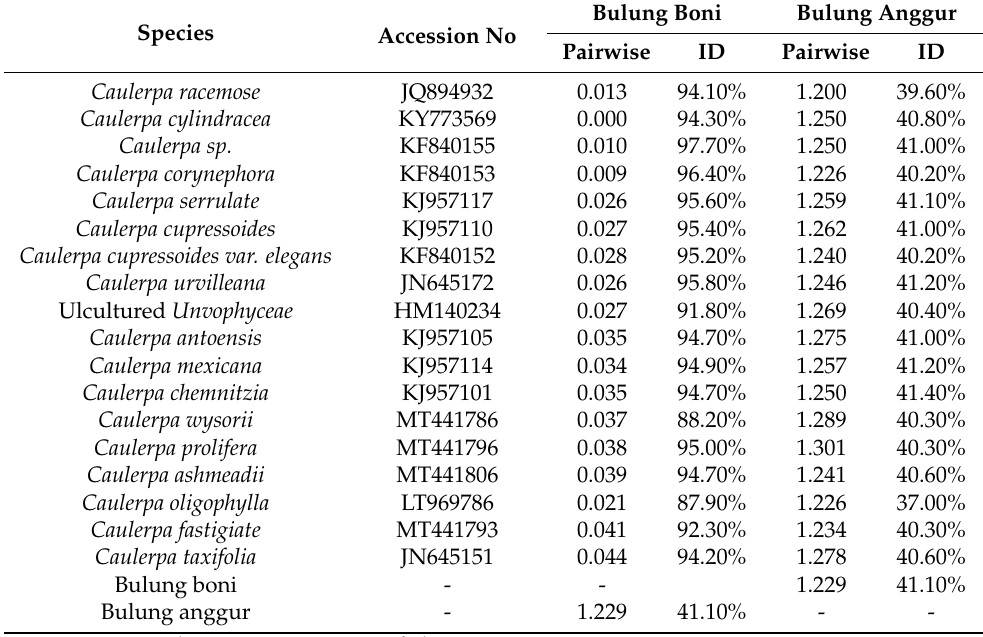
Pairwise, pairwise distance; ID, percentage of identity.